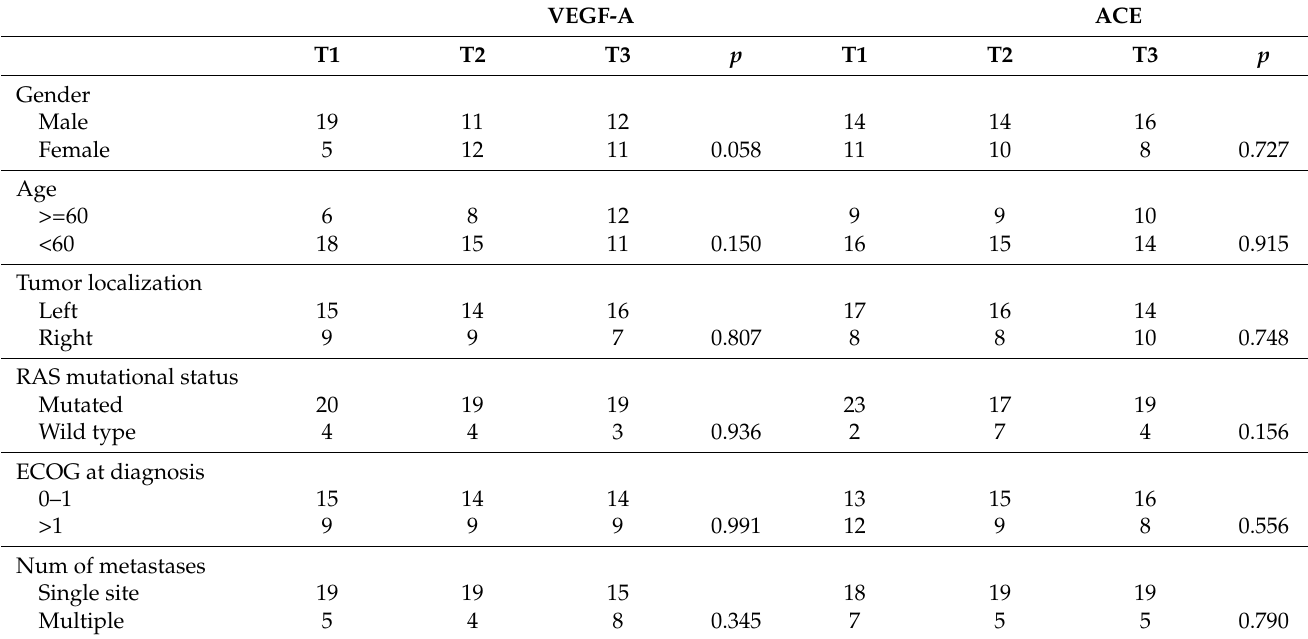
Table A1. Association between VEGF-A or ACE plasma levels and other clinical parameters.